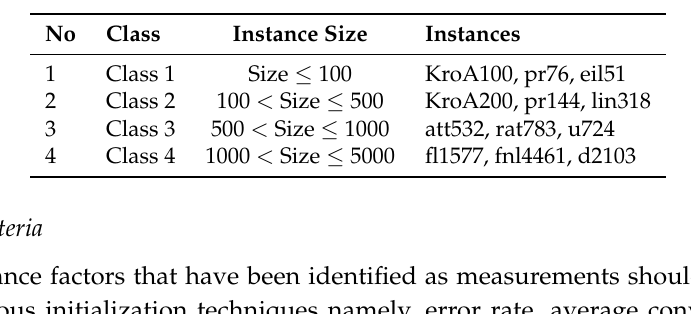
Table 2. Different sized TSP